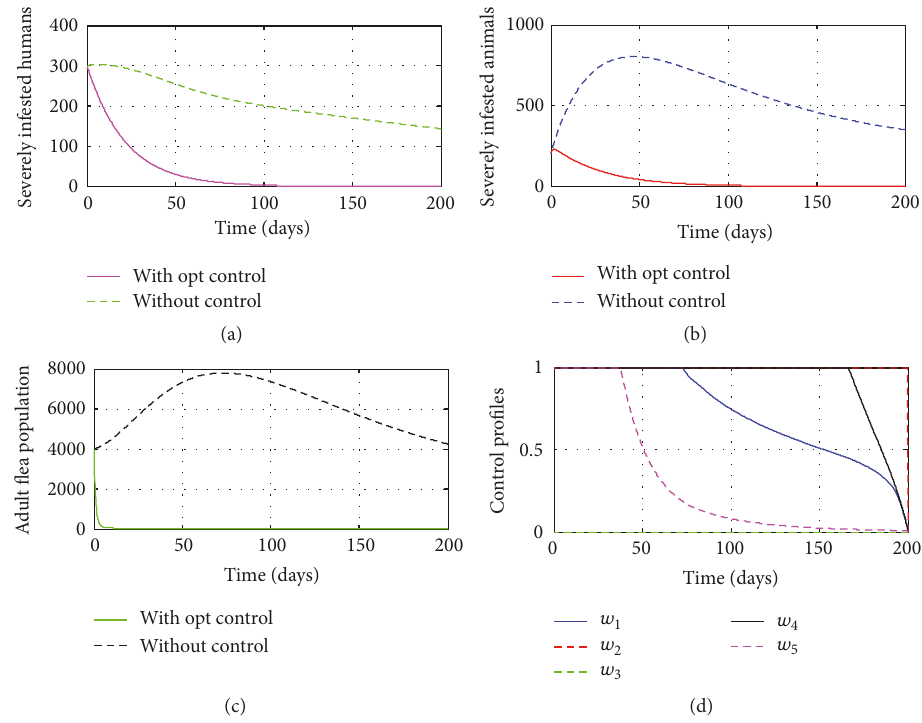
Figure 9: Optimal solutions for model variables 𝐼 𝐻ℎ , 𝐼 𝐴ℎ , 𝐹 𝐸 and the control profiles for 𝑤 1 , 𝑤 2 , 𝑤 3 , 𝑤 4 , 𝑤 5 with (𝑤 1 ,𝑤 2 ,𝑤 4 , 𝑤 5 ̸= 0)